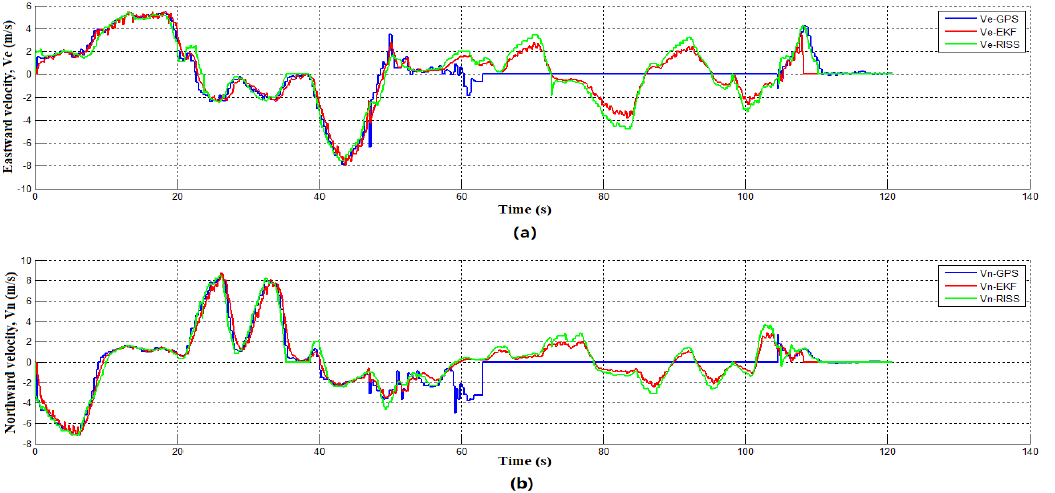
Figure 7. RISS velocity comparison diagram. ( a ) RISS eastward velocity comparison diagram; ( b ) RISS northward velocity comparison diagram.